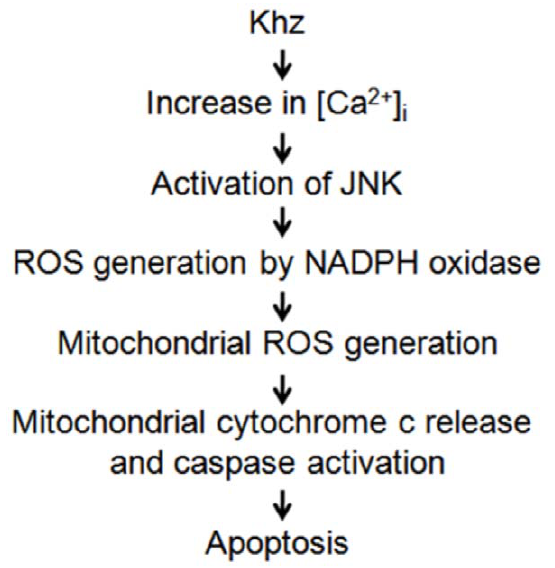
Figure 8. Summary of the signaling events leading to Khz- induced